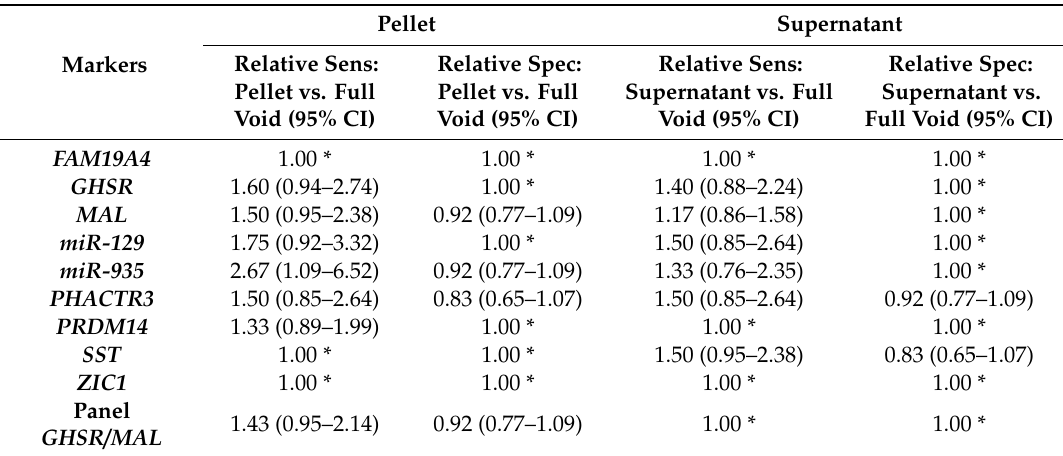
Table 4. Relative sensitivity and specificity of urine pellet and supernatant for bladder cancer diagnosis, as compared to full void. New cut-o ff s were determined for urine pellet and supernatant; optimal cut-o ff s from our previous study were used for full void